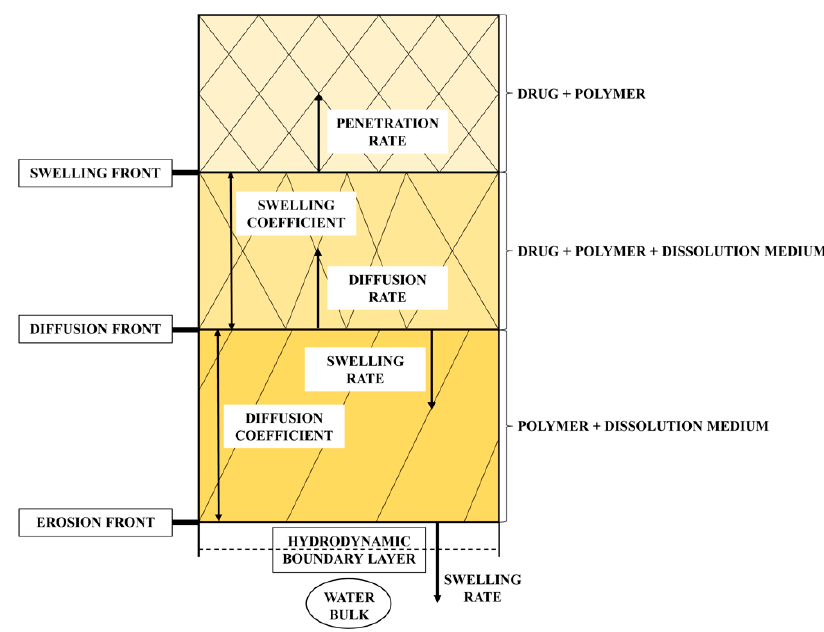
Figure 8. Scheme of front position during dissolution.